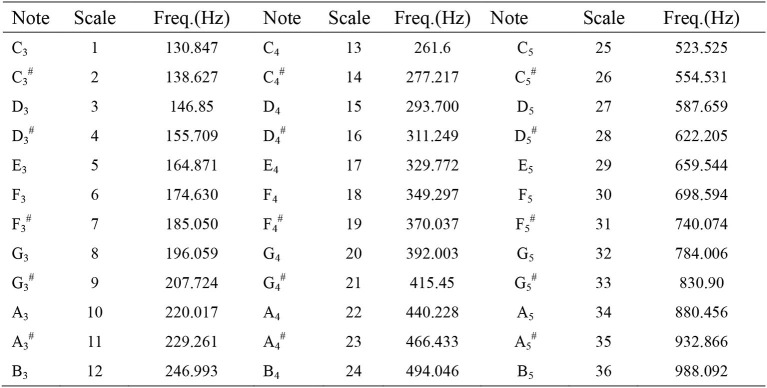
Musical note and scale to frequency chart. According to an electronic keyboard played from left to right in a standard soundproof room with multi-dimensional voice analysis software to measure and obtain the corresponding frequency, retaining all decimal points.